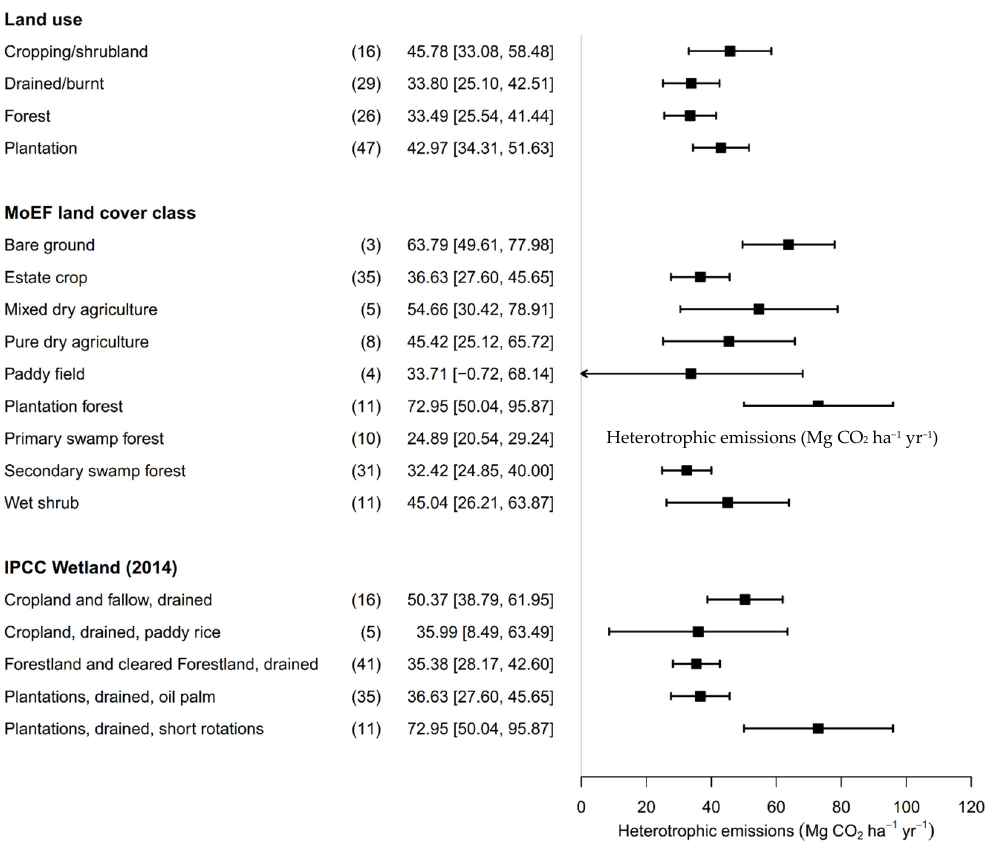
Figure 3. Heterotrophic emissions of Indonesia’ peatlands. For each land use and land cover class, the number of observations is provided in parentheses, followed by the mean and lower and upper bounds of the confidence interval in square brackets, separated by a comma.